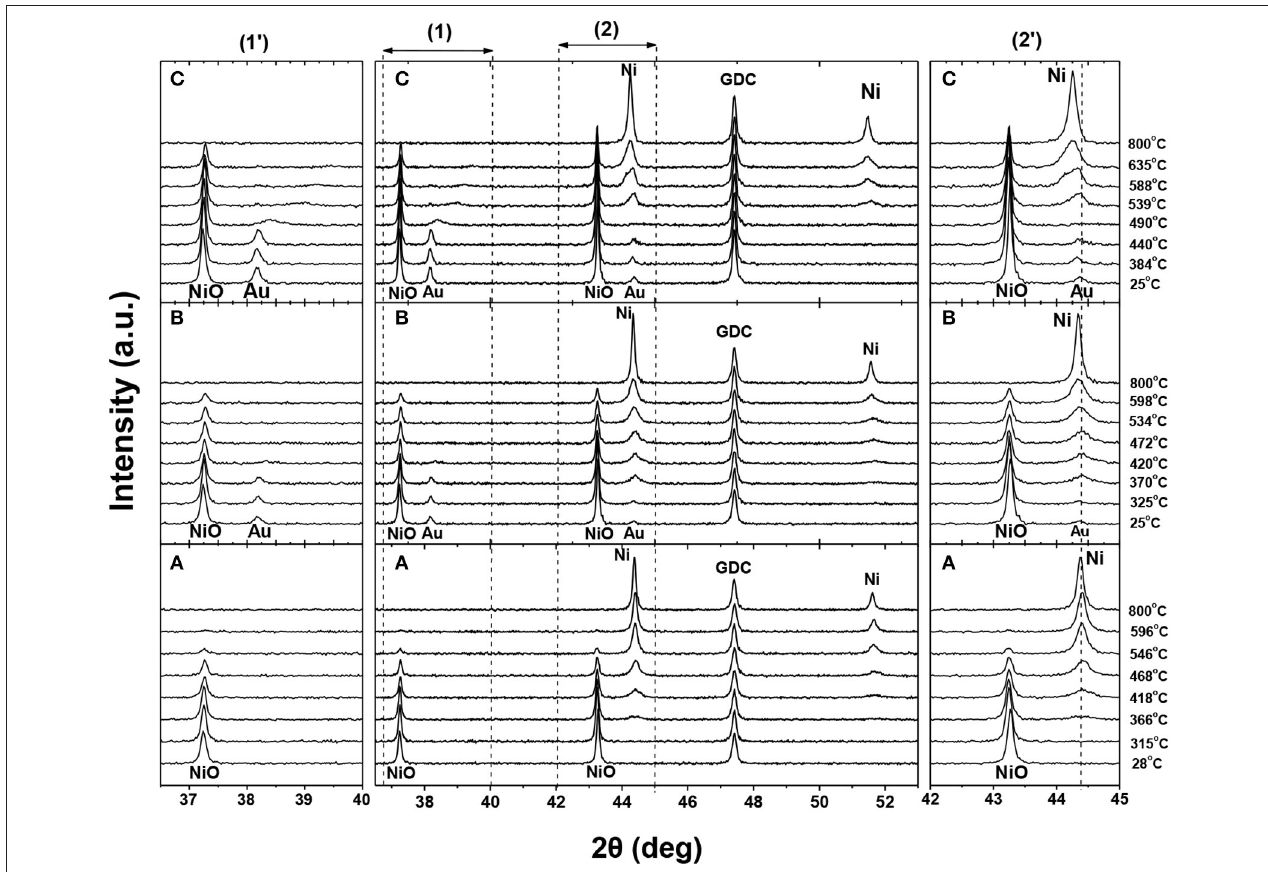
FIGURE 6 | XRD—TPR patterns of (A) blank Ni/GDC, (B) 3 wt.% Au-Ni/GDC (D.P.), and (C) 3 wt.% Au–30 wt.% Mo-Ni/GDC (D.CP.). During the XRD analysis all samples were in situ reduced under 2 vol% H 2 /N 2 , while the temperature increased from 50 to 800 ◦ C at a rate of 5 ◦ C min − 1 . The frames (1 ′ ) and (2 ′ ) depict the magnification of the dotted (1) and (2) areas. The labeled XRD peaks correspond to Au (JCPDS 04-0784), NiO (JCPDS 44-1159), GDC (JCPDS 46-0508), and Ni (JCPDS 04-0850). Reprinted with permission from Niakolas et al.